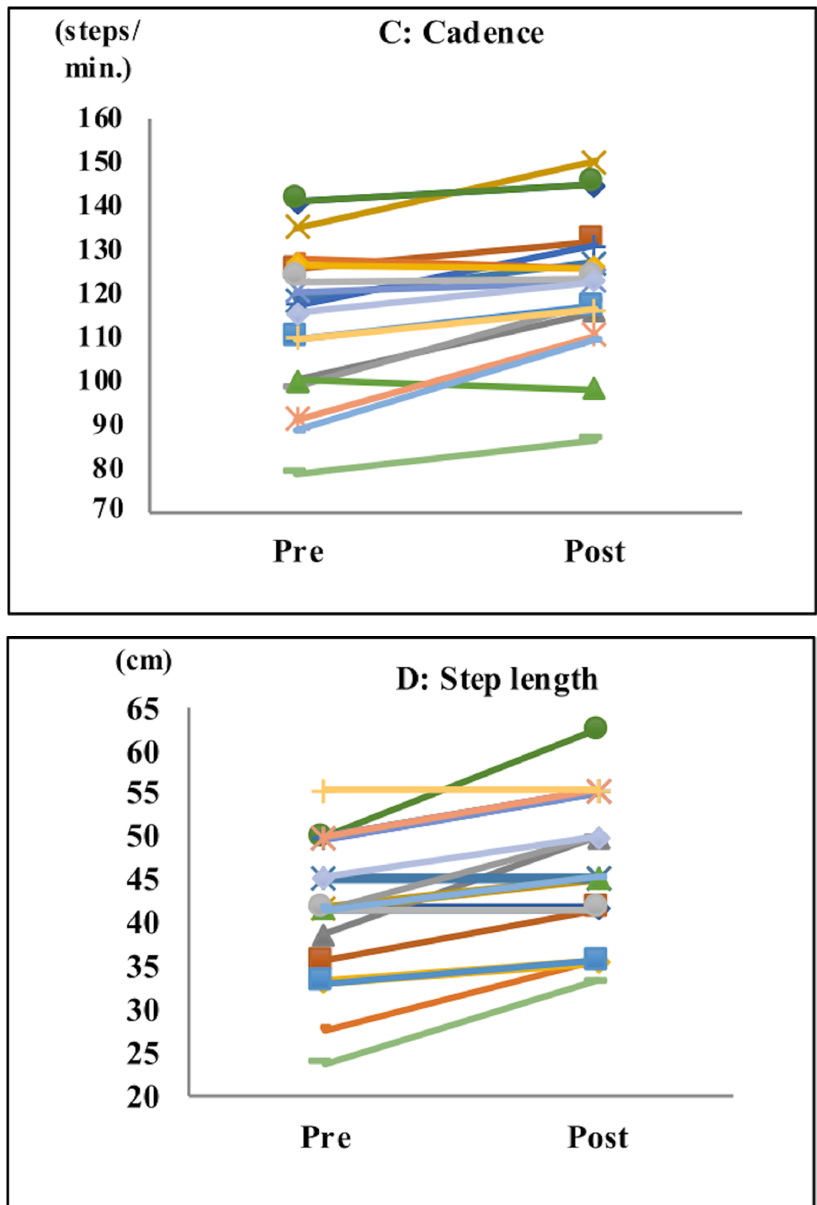
Figure 3. Gait parameters. Acceleration ( A ), gait speed ( B ), cadence ( C ), and step length ( D ). After